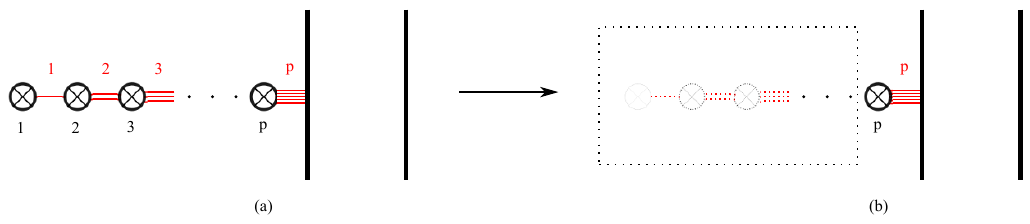
Figure 13 . In this (cid:12)gure we show how to relate the ( L the L irreducible ’t Hooft operator (b). This suggests that the tail of the reducible singular [ P; 0] monopole con(cid:12)guration is analogous to the subleading terms in the